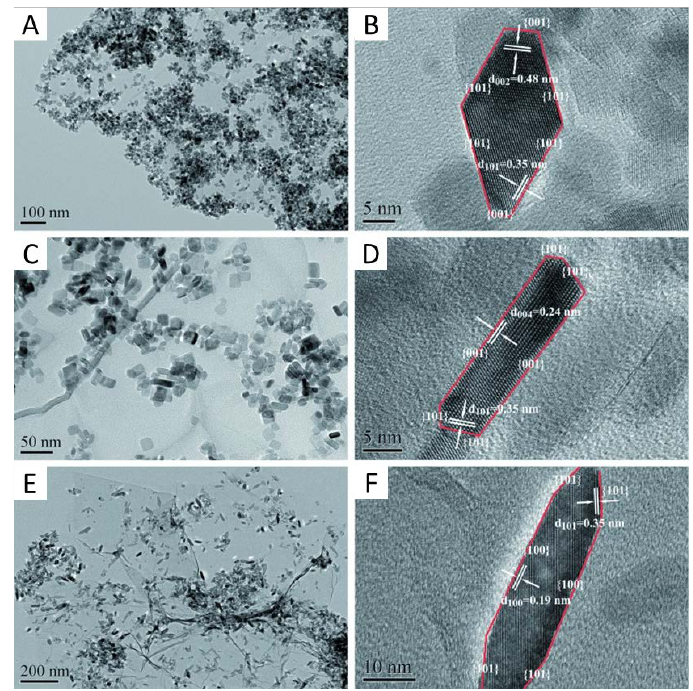
Figure 6. TEM and HRTEM images of: ( A , B ) TiO 2 -101-G, ( C , D ) TiO 2 -001-G, and ( E , F ) TiO 2 -100-G.